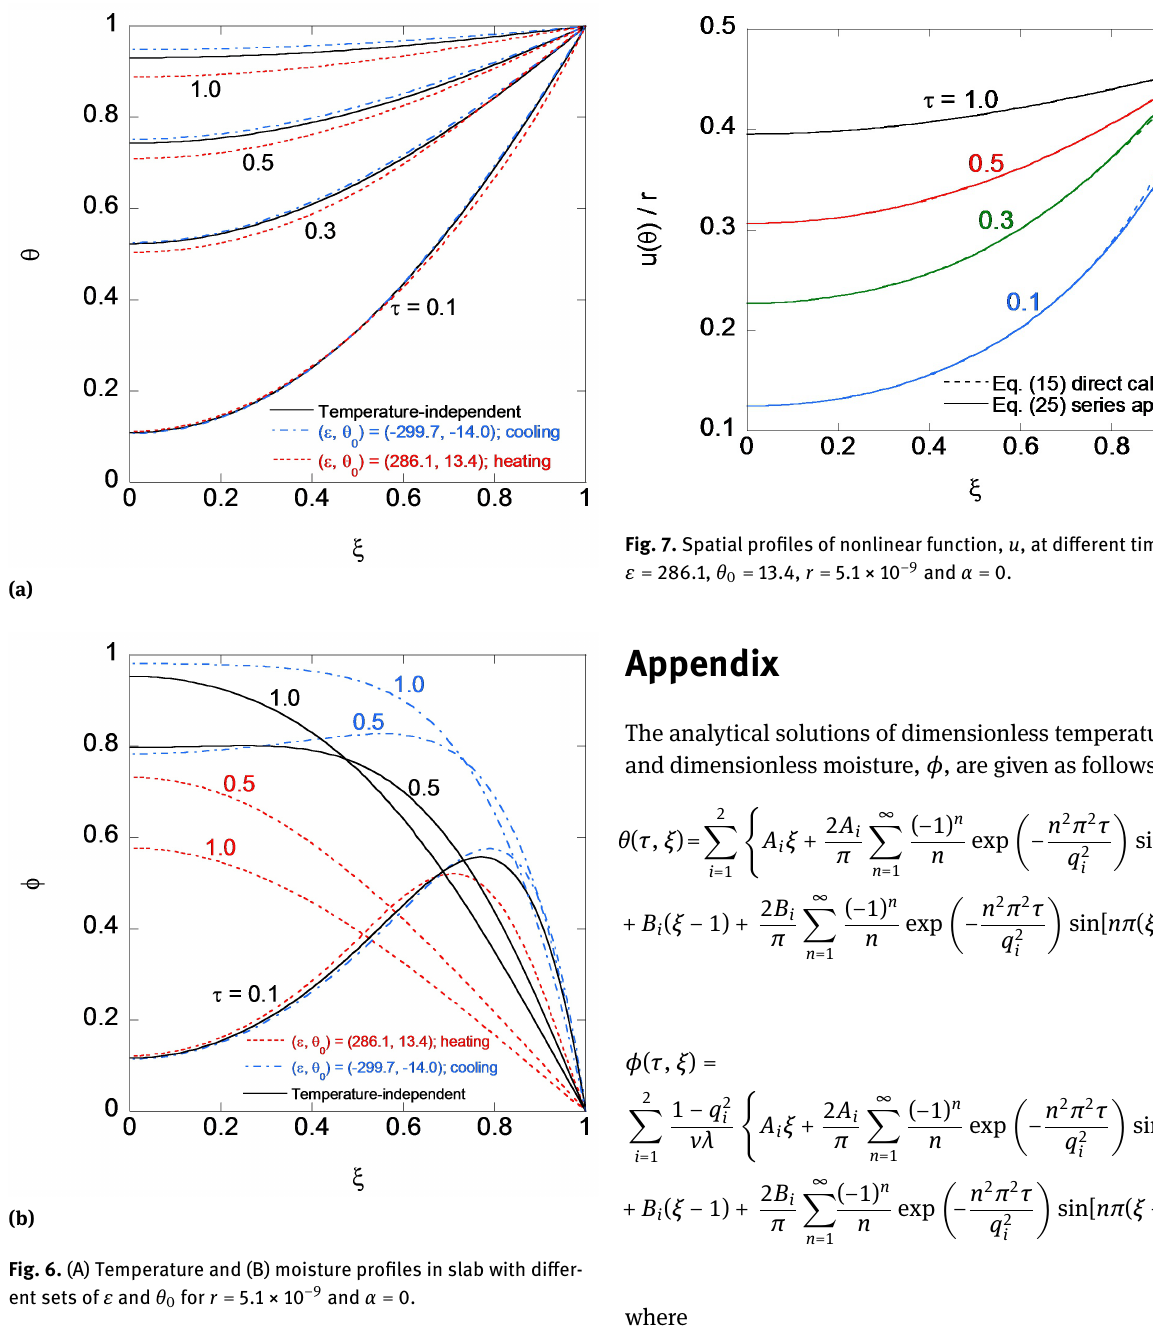
In the present study, a versatile approach proposed by Chang et al. [38] has been used to treat complex nonlinear terms, including Eq. (15), on the DTM. Instead, the appli- cation of a novel treatment developed by Ebaid et al. [39] for multiple nonlinear terms may improve computational efficiency.